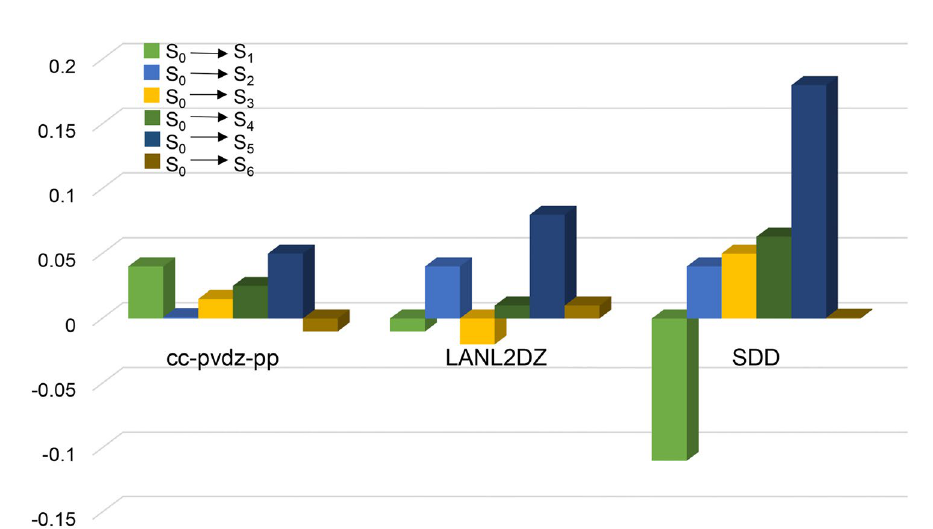
Figure 3. Errors of the first six excited state transition energies between aug-cc-pVDZ-pp and other three basis sets for Cd 2 S